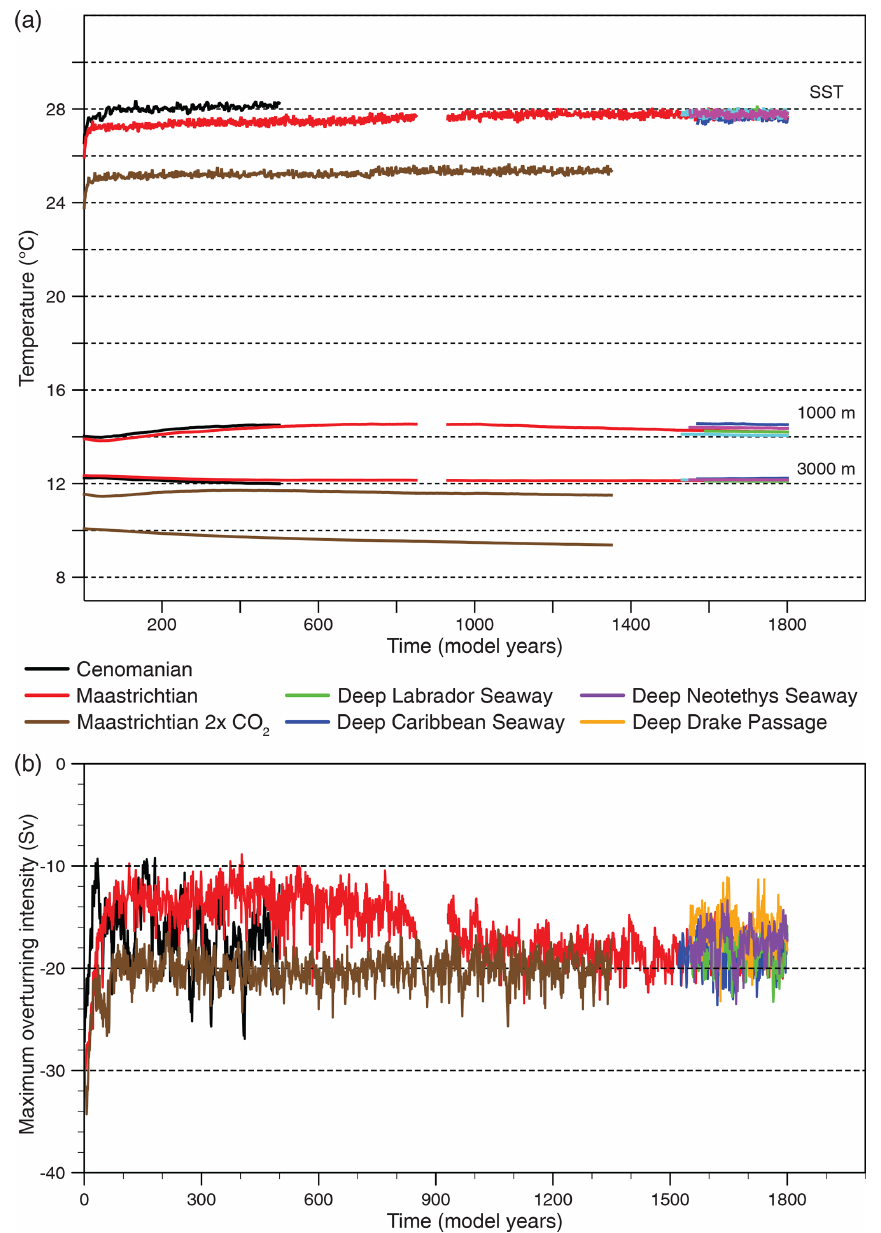
Figure 2. (a) Time series of temperature at the sea surface and in the intermediate (1000m) and deep (3000m) ocean, showing that the model has reached quasi-equilibrium at the end of the simulations. The gap between years 850 and 930 in the Maastrichtian simulation (red line) is due to unfortunate loss of data. Only the ends of the sensitivity simulations (Deep Labrador Seaway, Deep Drake Passage, Deep Caribbean Seaway, and Deep Neotethys Seaway) are shown because the full history of the evolution of these simulations was not conserved. Note that the first 1500 years of the simulations, described in Tabor et al. (2016), are omitted on this figure. (b) Time series of the meridional overturning circulation. Note that the maximum overturning intensity is negative because the circulation is